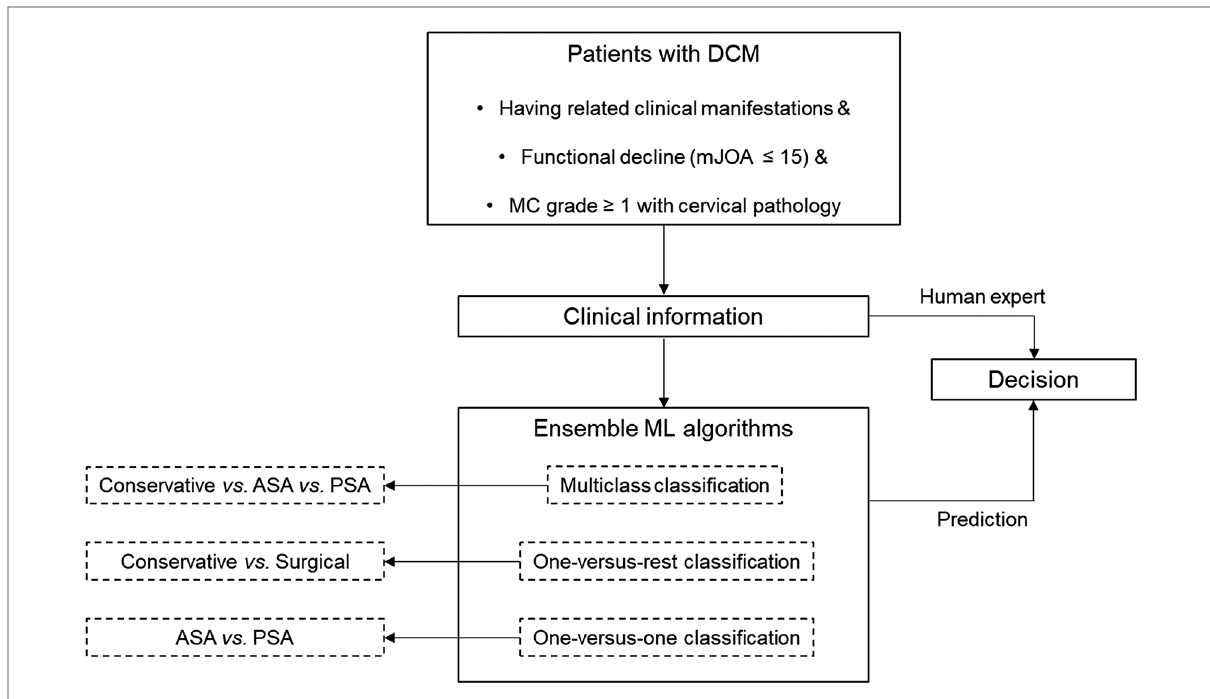
FIGURE 1 Schematic architecture of the study design. ASA, anterior surgical approaches; DCM, degenerative cervical myelopathy; MC, Muhle ’ s classi fi cation; mJOA; modi fi ed Japanese Orthopaedic Association score; PSA, posterior surgical